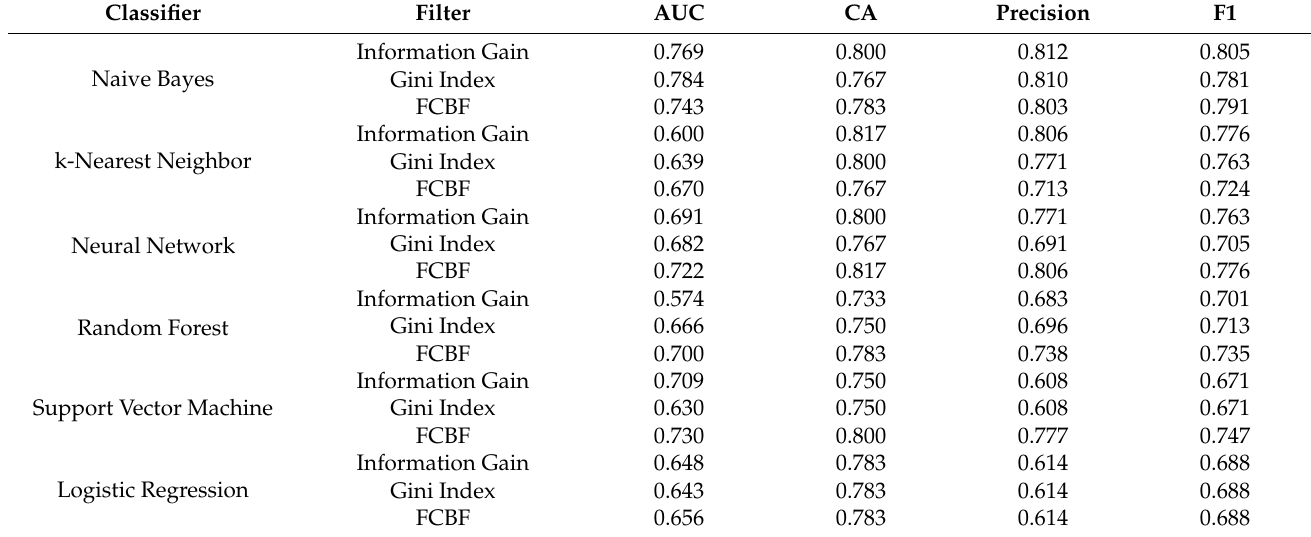
Table 3. Model performance grouped by feature selection filter and machine learning classifier on the testing data set.